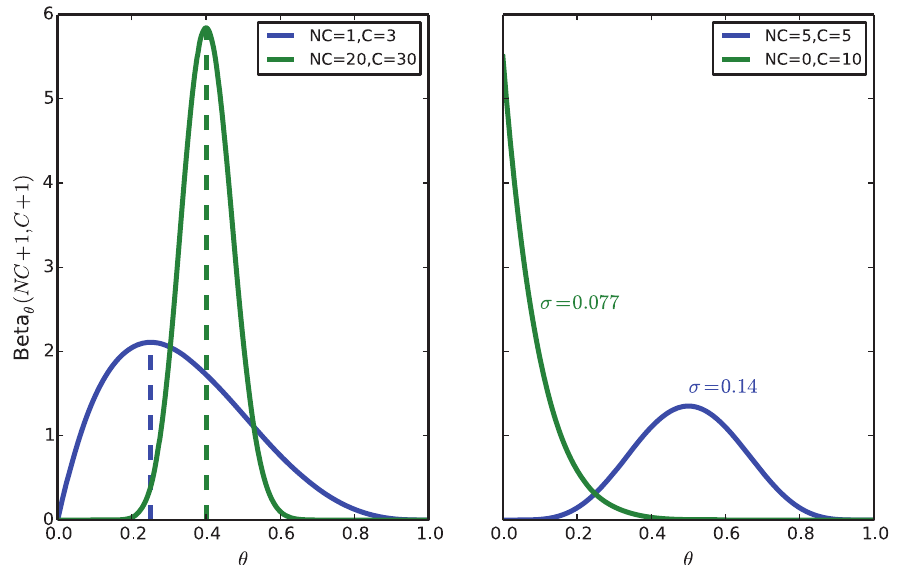
Figure 4. Effects of coverage on P ( h 1 w h 2 ) . In the left panel we show that a sample for which the methylation is estimated (with high uncertainty) to be low can be (with some probability) more methylated than a sample for which the methylation level is higher, and certain. In the right panel : even if the total coverage is the same, the uncertainty over h varies according to the count of non converted (NC) and converted (C) reads.